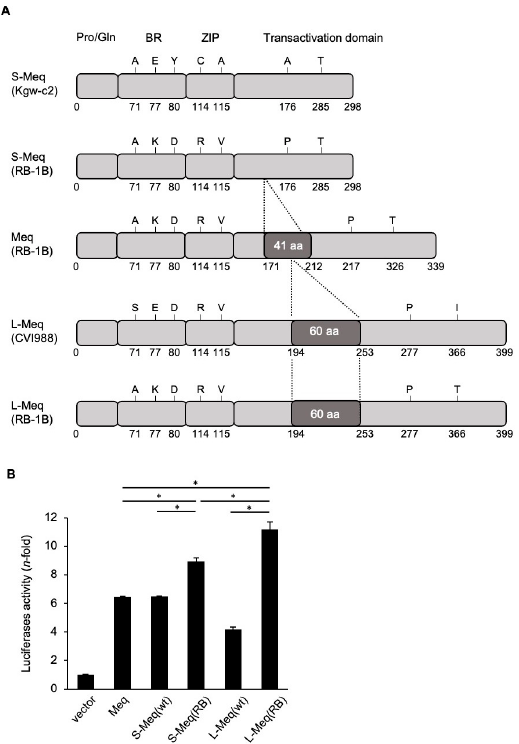
Figure 1. Analysis of the transactivation activity of the three Meq isoforms. ( A ) Schematic represen- tation of the different Meq isoforms. The structures of short-Meq containing the deletion (S-Meq) from Kgw-c2, a Marek’s disease virus (MDV) strain, Meq from RB-1B, and long-Meq containing the insertion (L-Meq) from CVI988, and S-Meq (RB-1B) and L-Meq (RB-1B) whose sequences were matched with that of RB-1B-Meq, except for the deletion or insertion in the transactivation domain, are indicated. Meq comprises a proline/glutamine (Pro/Gln) rich domain followed by the basic region (BR) and leucine zipper (ZIP) at the N-terminal region, and the transactivation domain at the C-terminal region. The Meq isoforms include mutations in the BR, ZIP, and transactivation domain. S-Meq contains a 41 amino acid deletion in the transactivation domain and L-Meq is characterized by a 60-amino acid insertion in the transactivation domain. ( B ) Transactivation activity of the Meq isoforms. The transactivation activity of RB-1B-Meq, wild-type S-Meq (Kgw-c2), wild-type L-Meq (CVI988), S-Meq (RB-1B), and L-Meq (RB-1B) was compared on the Meq promoter-driven luciferase activities. DF-1 cells in each well were transfected with 300 ng of expression plasmids, Meq, S-Meq (wild-type), S-Meq (RB-1B), L-Meq (wild-type), or L-Meq (RB-1B); 200 ng of the c-Jun expression plasmid; 500 ng of the reporter plasmid; and 5 ng of control pRL-TK. Luciferase activities were analyzed 24 h post-transfection. Firefly luciferase activity is expressed relative to the mean basal activity in the presence of pCI-neo after normalization to Renilla luciferase activity. Error bars indicate standard deviations. * p <